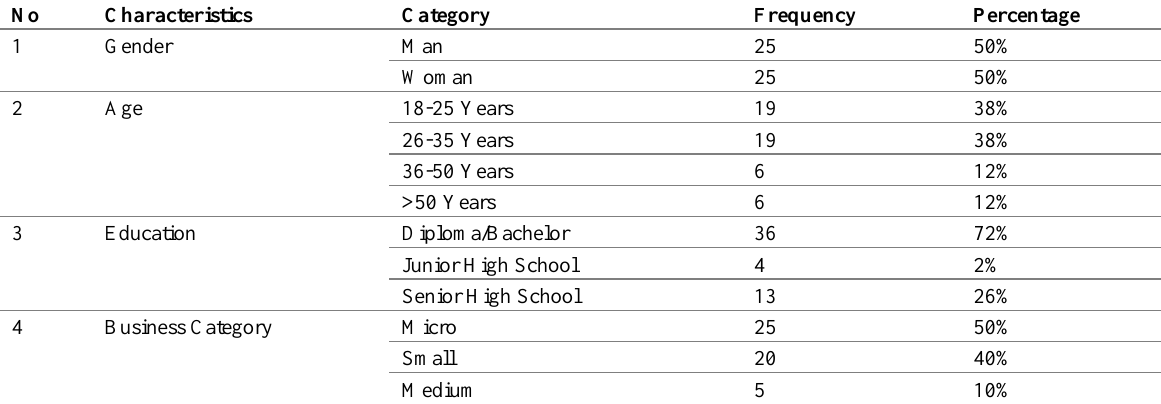
Table 1: Respondent